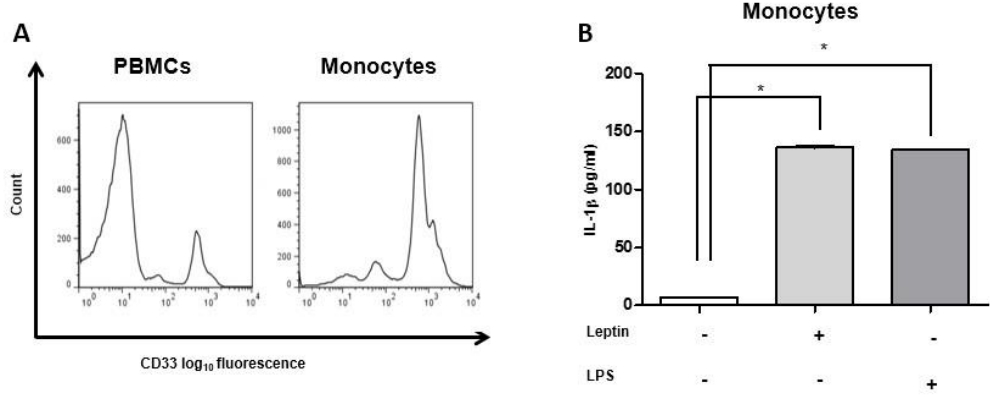
Figure 5. Monocytes were isolated from healthy donors using anti-CD14 magnetic beads; ( A ) Purity was tested with positivity to an anti-CD33 antibody. Monocytes were cultured in RPMI1640 and stimulated with ~20 pg/mL of leptin for 18 h. Afterward, IL-1 β secretion was measured; ( B ) ~20 pg/ml of leptin was able to induce a significant release of IL-1 β from monocytes, which was comparable to LPS positive control. PBMCs have been treated with LPS 1.5 µ g/mL for 18 h. Data are expressed as mean ± SEM for three healthy donors and were analyzed with the Wilcoxon–Mann–Whitney U Test (* p < 0.005). PBMC: peripheral blood mononuclear cells; IL-1 β : interleukin-1 β ; LPS: lipopolysaccharide.